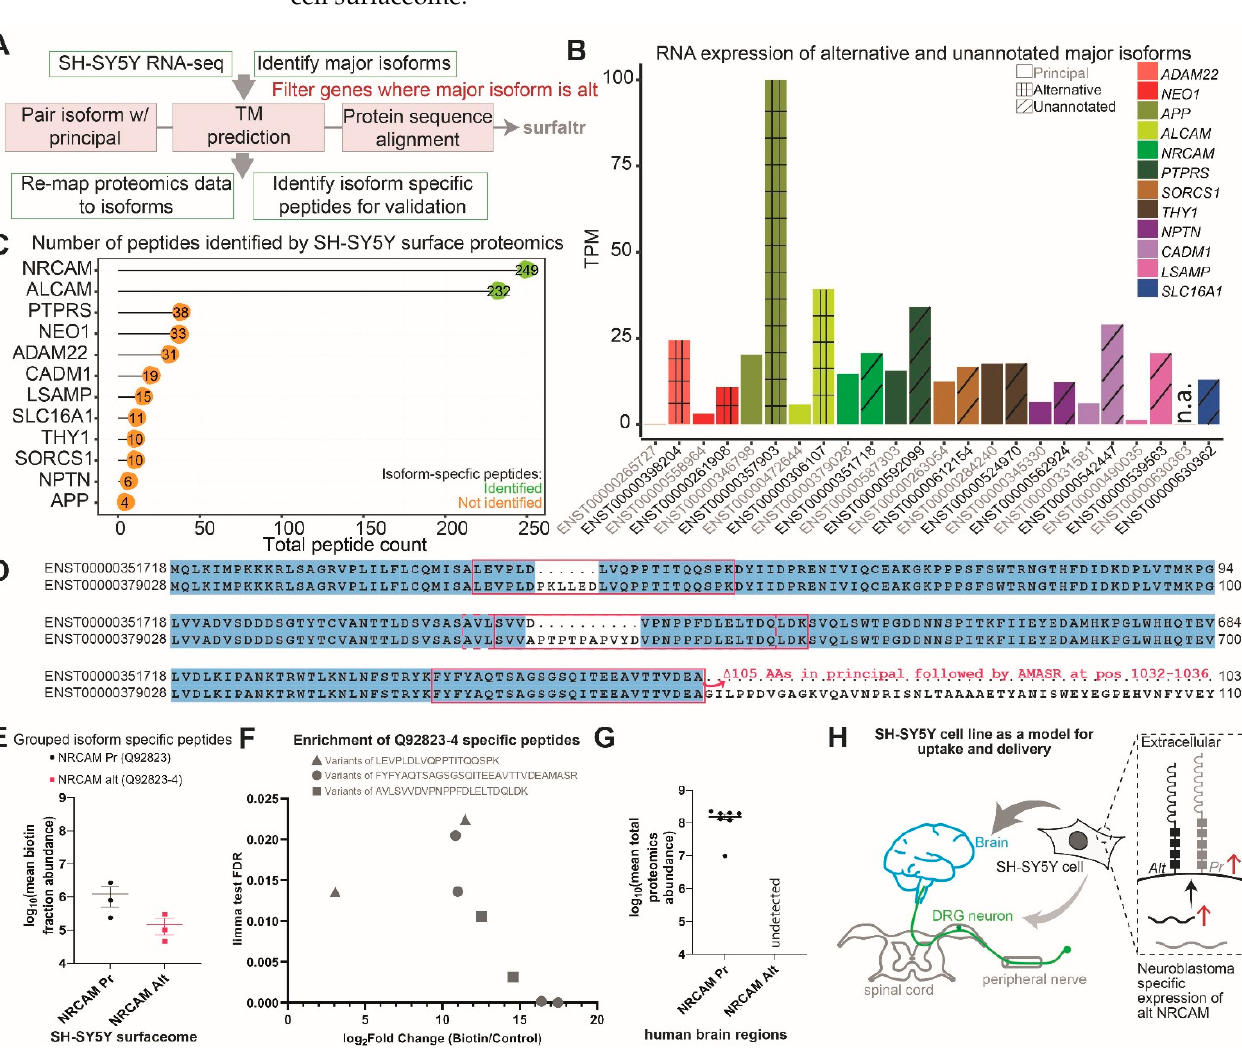
Figure 3. Alternatively spliced major isoforms expressed on the surface of SH-SY5Y cells. ( A ) Schematic describing the bioinformatics pipeline for identification of surface protein isoforms expressed on SH-SY5Y cells by using both proteomics and transcriptomics data. Grey boxes describe all the analyses included in the surfaltr R package (details in the methods section). ( B ) Barplot showing RNA expression of alternatively spliced and APPRIS-unannotated major isoforms for surface protein-coding isoforms expressed in SH-SY5Ycells and common to the brain and DRG tissues. Isoform quantification for all transcripts listed in Table S4. Alternative, principal, and unannotated isoforms are shaded as indicated in the legend. ( C ) Total number of peptides identified via surface proteomics for alternatively spliced and APPRIS-unannotated major isoforms described in ( C ). ( D ) Protein sequence alignment of NRCAM alternatively spliced (NRCAM alt, ENST00000351718) SH-SY5Y specific major isoform to NRCAM APPRIS-annotated principal isoform (NRCAM Pr, ENST00000379028). Regions where the two isoforms differ in sequence have been highlighted by the red box. The red arrow followed by text indicate sequence of the NRCAM alt isoform